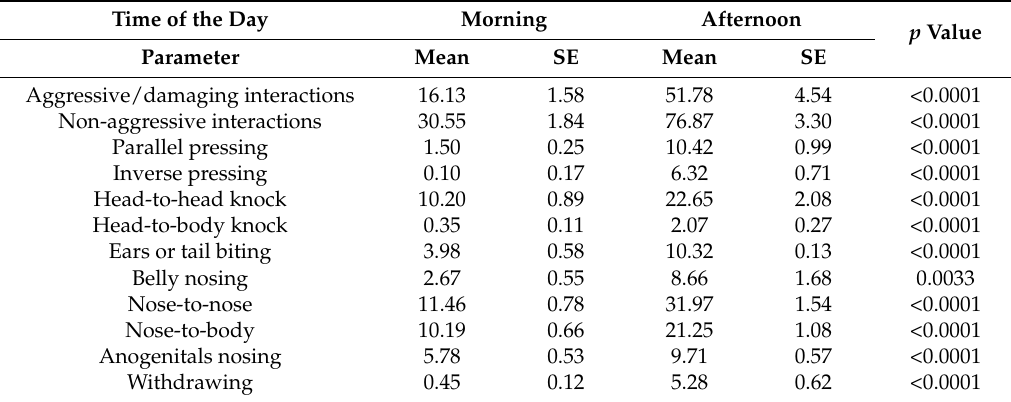
Table 8. Social interactions at different timed of the day (%).